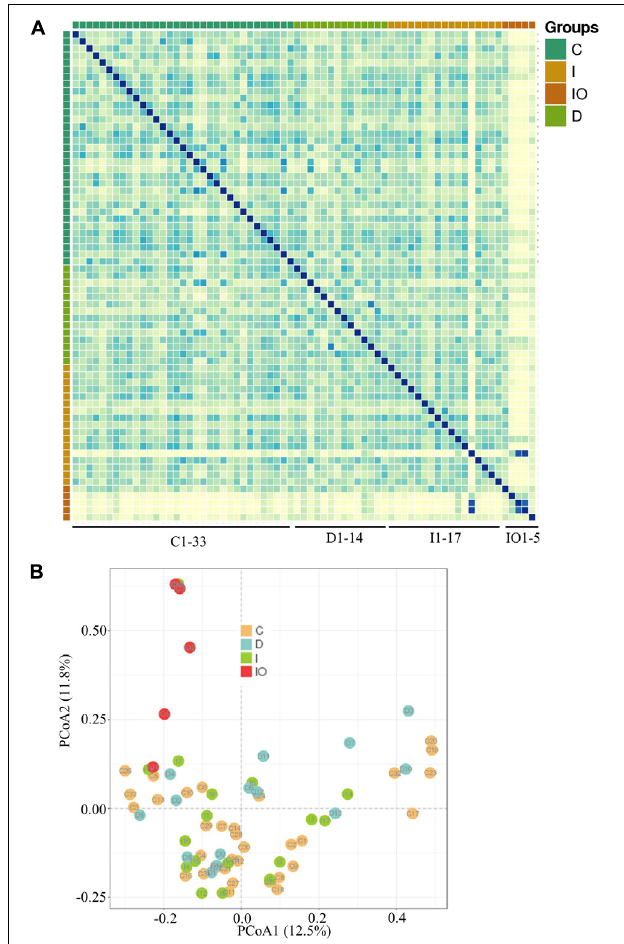
FIGURE 2 | Representation of microbial beta-diversity. Heatmap representation (A) and PCoA (B) based on Brey-Curtis similarity.